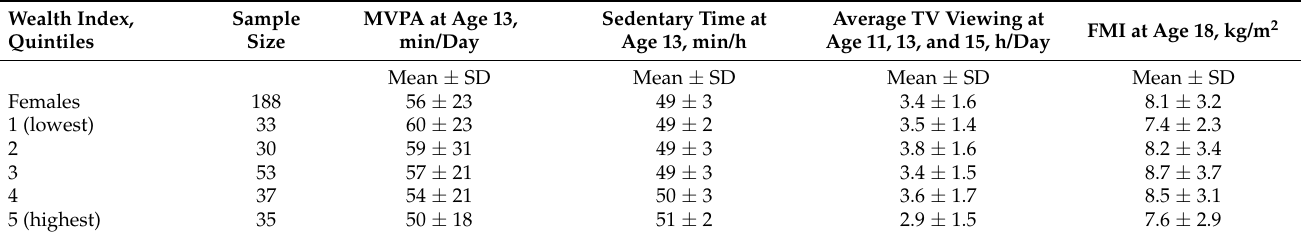
Table 2. Means of MVPA, sedentary time, TV viewing, and FMI according to wealth index quintiles among